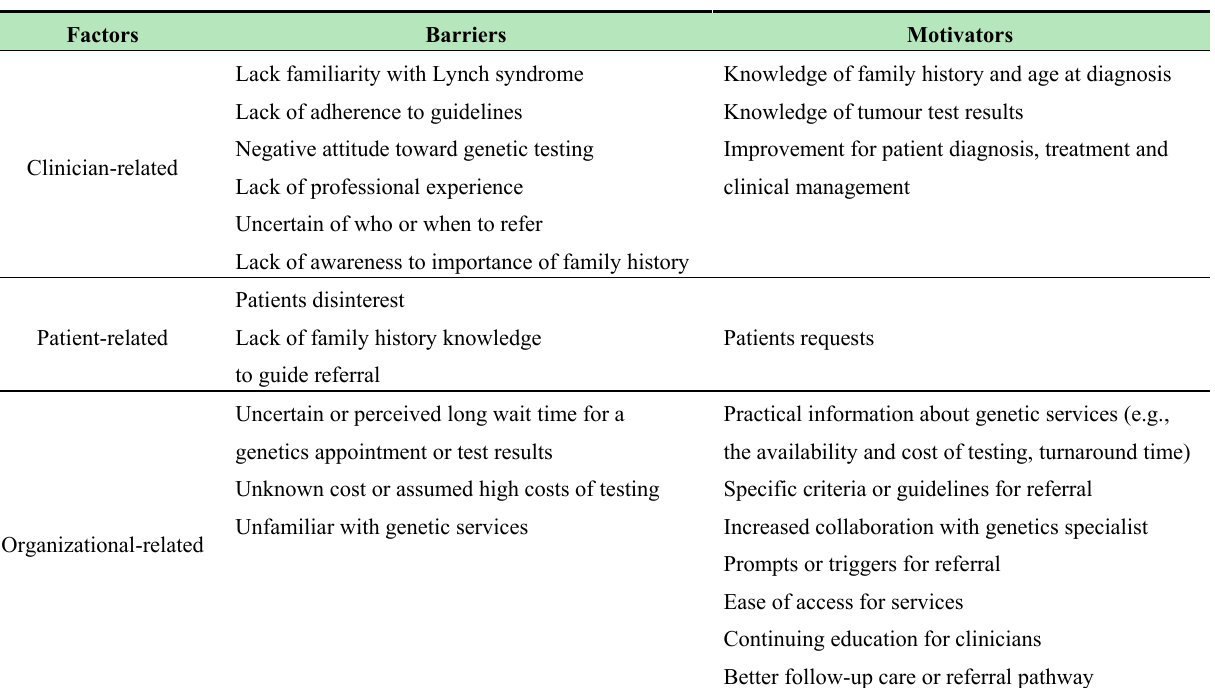
Table 2. Summary of barriers and motivators for genetics referral of patients with suspected Lynch